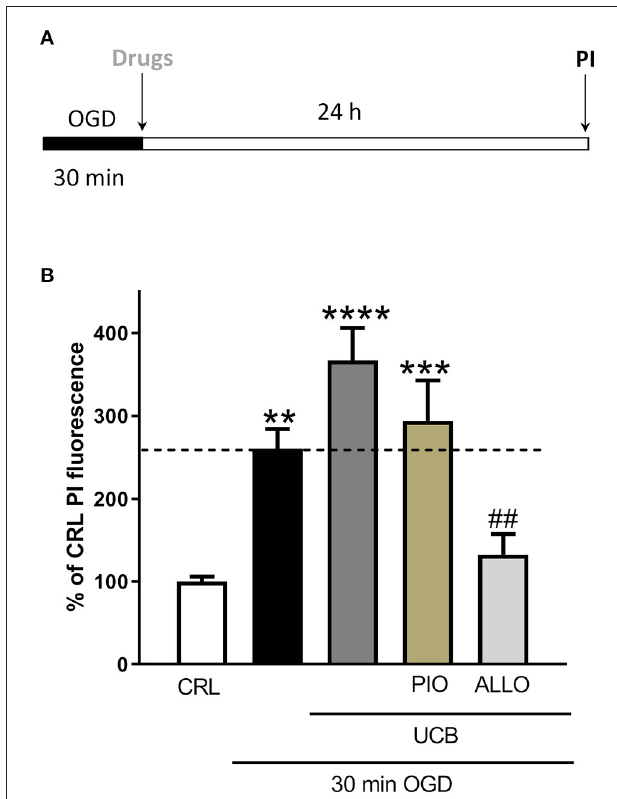
FIGURE 2 | Effects of pioglitazone and allopurinol on unconjugated bilirubin (UCB)-induced-toxicity in OGD mature organotypic hippocampal slices. (A) Experimental protocol showing mature hippocampal slices subjected to 30min OGD and then to UCB (100) and pioglitazone (10 µ M) or allopurinol (10 µ M) for 24h. (B) Quantitative analysis shows that the addition of allopurinol but not pioglitazone reduces cellular death induced by UCB, measured by the intensity of PI fluorescence. Bars represent the mean ± SEM of at least seven experiments (about ≥ 44 slices for each experimental point). ** P < 0.01 vs. CRL; *** P < 0.001 vs. CRL; **** P < 0.0001 vs. CRL; ## P < 0.01 vs.